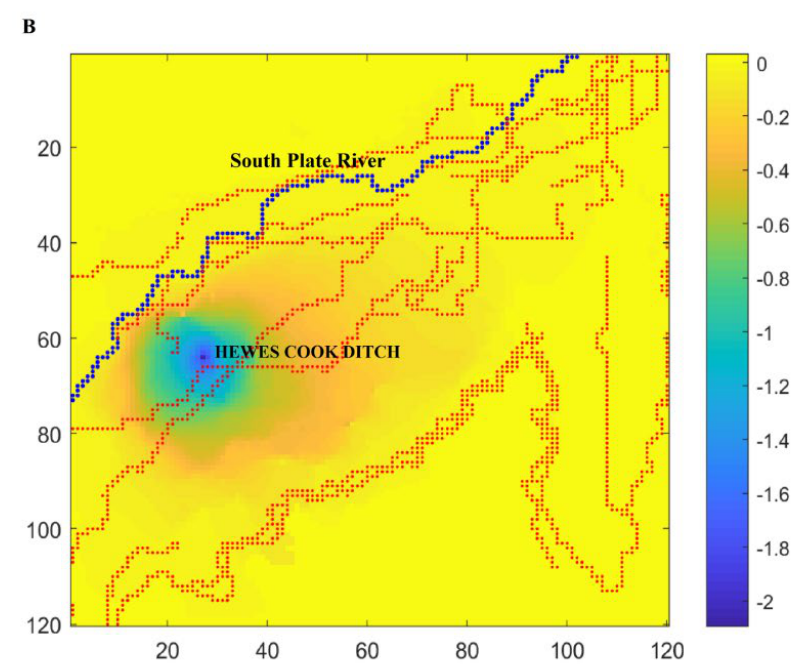
Figure 11. Figure ( A ) is the average head decrease (m) as each recharge pond is removed from the simulation. Figure ( B ) is the head drop (m) map corresponding to Recharge Pond #28.